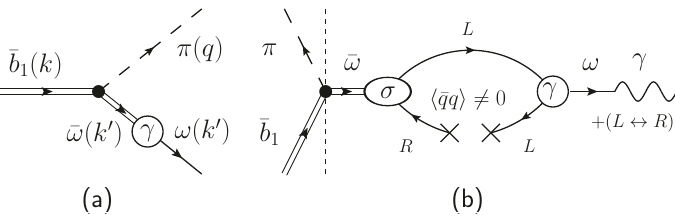
Figure 1 . The ¯ b 1 decay in chiral representation. (a) ¯ b 1 ¯ b 1 → πγ in the VMD hypothesis inferred from eq. (3.21). Double lines denote the spin-1 mesonic states in tensor representation. The greek letters, ‘ σ ’ and ‘ γ ,’ in the blob represent the tensor and vector current representation,